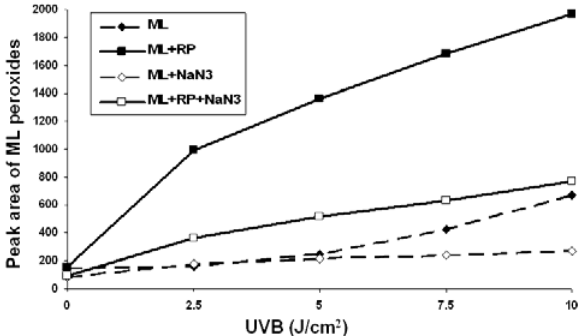
18 Figure 6: Lipid peroxidation induced by photoirradiation of RP with UVB light, and inhibitory effect of NaN peroxidation of methyl linoleate. The levels of peroxidation were measured by HPLC analysis in